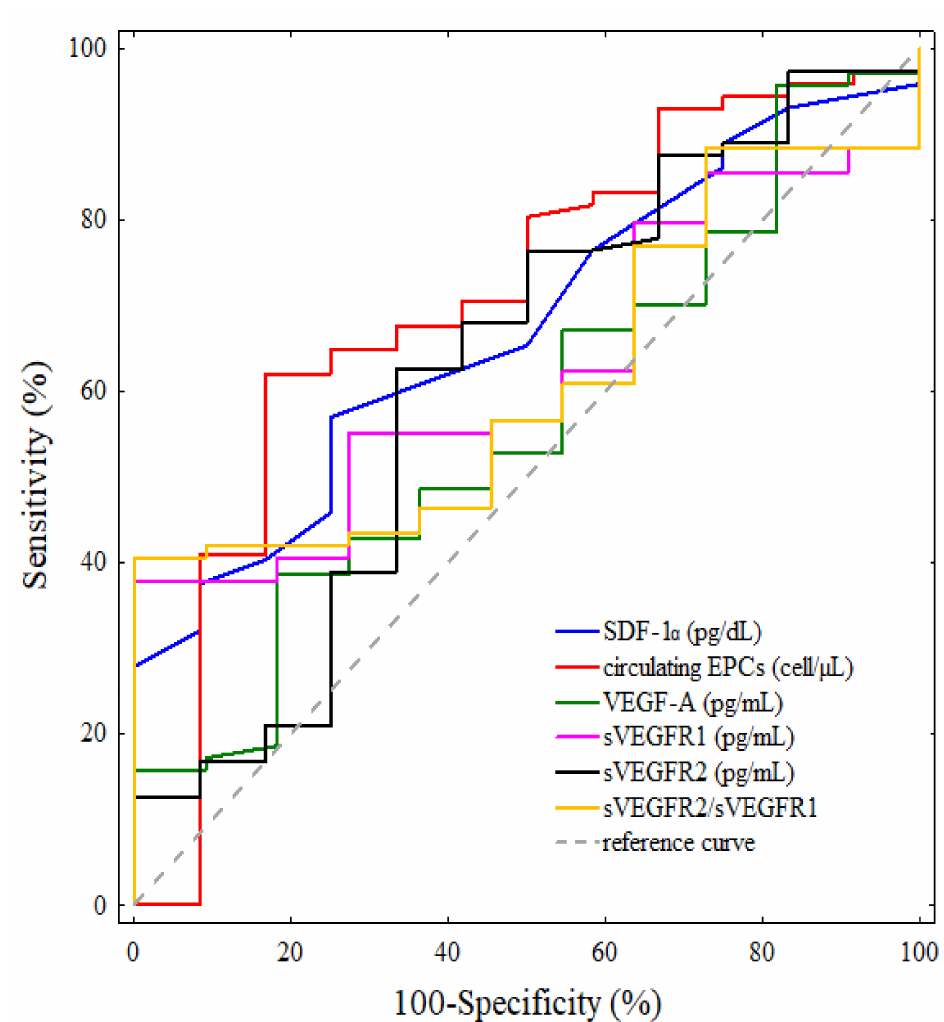
Figure 1. Receiver operating characteristic (ROC) curves for single biomarker detection in pre- dicting disease-free survival in IBrC patients. SDF-1 α - AUC = 0.674; p = 0.0162, circulating EPCs- AUC = 0.708; p = 0.0131, VEGF-A- AUC = 0.568; p = 0.4410, sVEGFR1- AUC = 0.622; p = 0.0906, sVEGFR2- AUC = 0.620; p = 0.1990, sVEGFR2/sVEGFR1- AUC = 0.613; p = 0.1267. As well as the ROC curves for the separate laboratory parameters, we generated a ROC curve for the tested model consisting of the SDF-1 α , VEGF-A, sVEGFR1, sVEGFR2 concentrations and the number of circulating EPCs as well as the sVEGFR2/sVEGFR1 ratio. For all these parameters, the area under the curve was 0.881 ( p = 0.0003) (Figure 2). Thus, this combination of parameters involved in vasculogenesis, angiogenesis and chemo- taxis demonstrates a deeper molecular link between these processes but also great prog- nostic